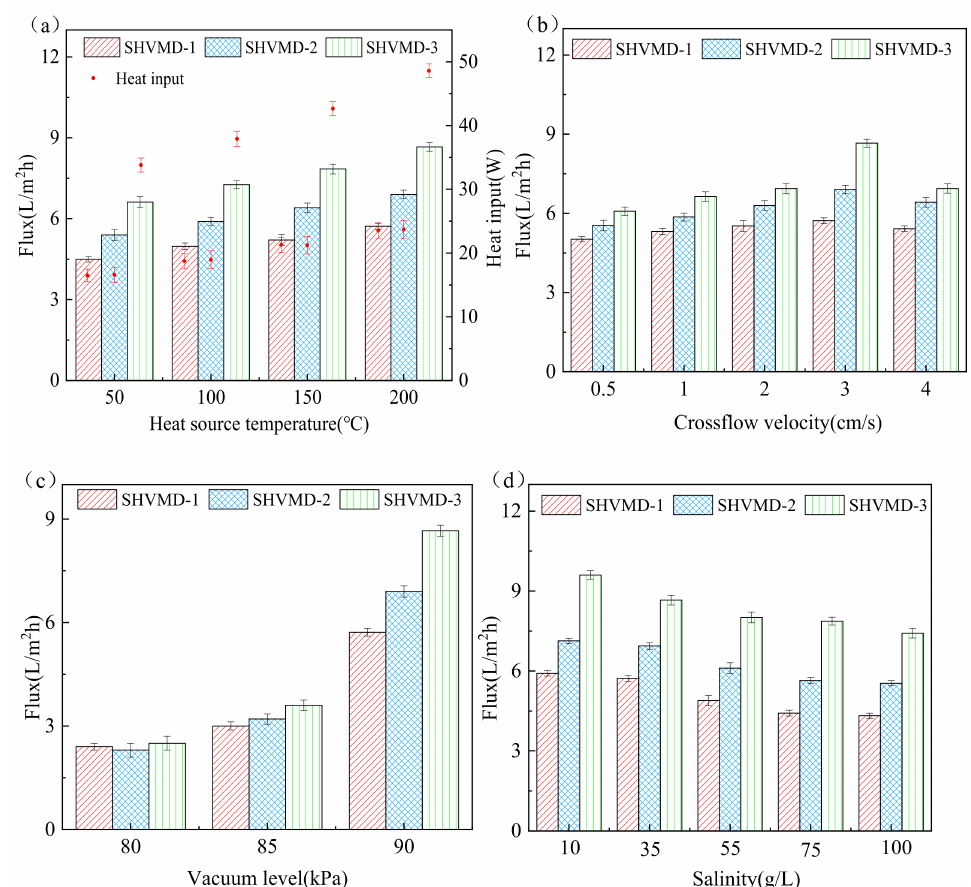
Figure 2. Heat input and distillate flux in 2 h tests with different system configurations. The flux and heat input of SHVMD-1, SHVMD-2, and SHVMD-3 were measured as a function of ( a ) heat source temperature, ( b ) crossflow velocity, ( c ) vacuum level, and ( d ) salinity. Regarding the operating conditions, unless specified as the variable, the heater temperature was 200 ◦ C, crossflow velocity was fixed at 3 cm/s, vacuum level was kept at 90 kPa, and salinity was 35